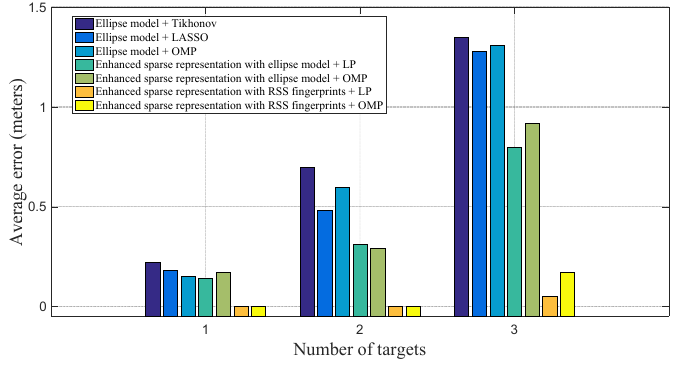
Figure 6. Average localization accuracy in the indoor LOS scenario.